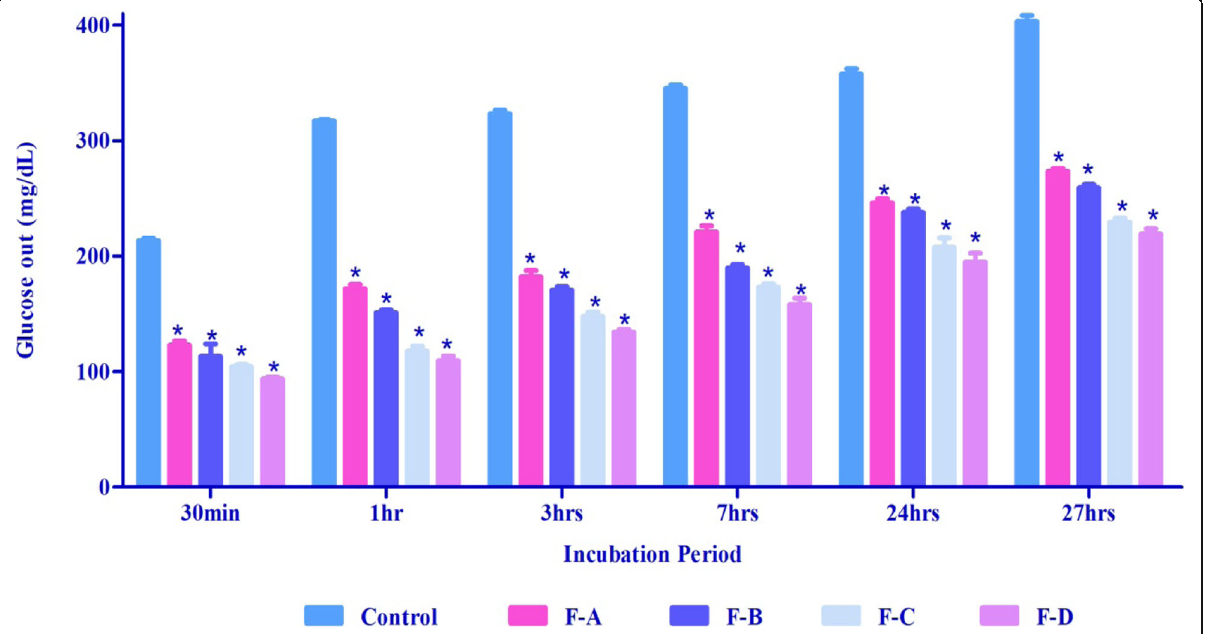
Fig. 5 Effect of isolated pooled fractions (50 g/L) obtained from MeCV on the movement of glucose out of dialysis tube over 27-h incubation. Each vertical bar represents mean ± SE ( n = 6) the vertical bars differ significantly compared to the control group at * P < 0.001 (one-way ANOVA by Dunnett ’ s